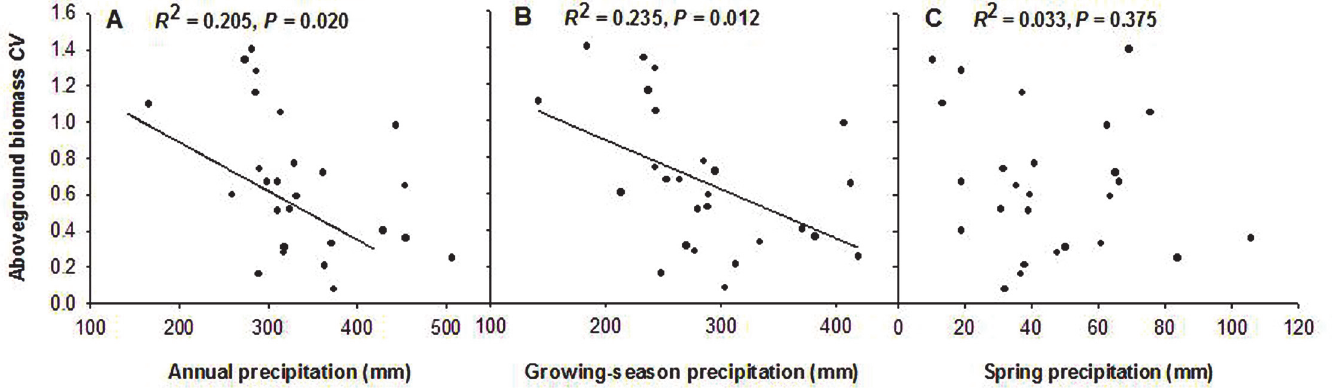
Fig 3. Relationship between coefficient of variation aboveground biomass of annuals and precipitation (1982 – 2012). (A) Annual precipitation; (B) Growing-season precipitation; (C) Spring